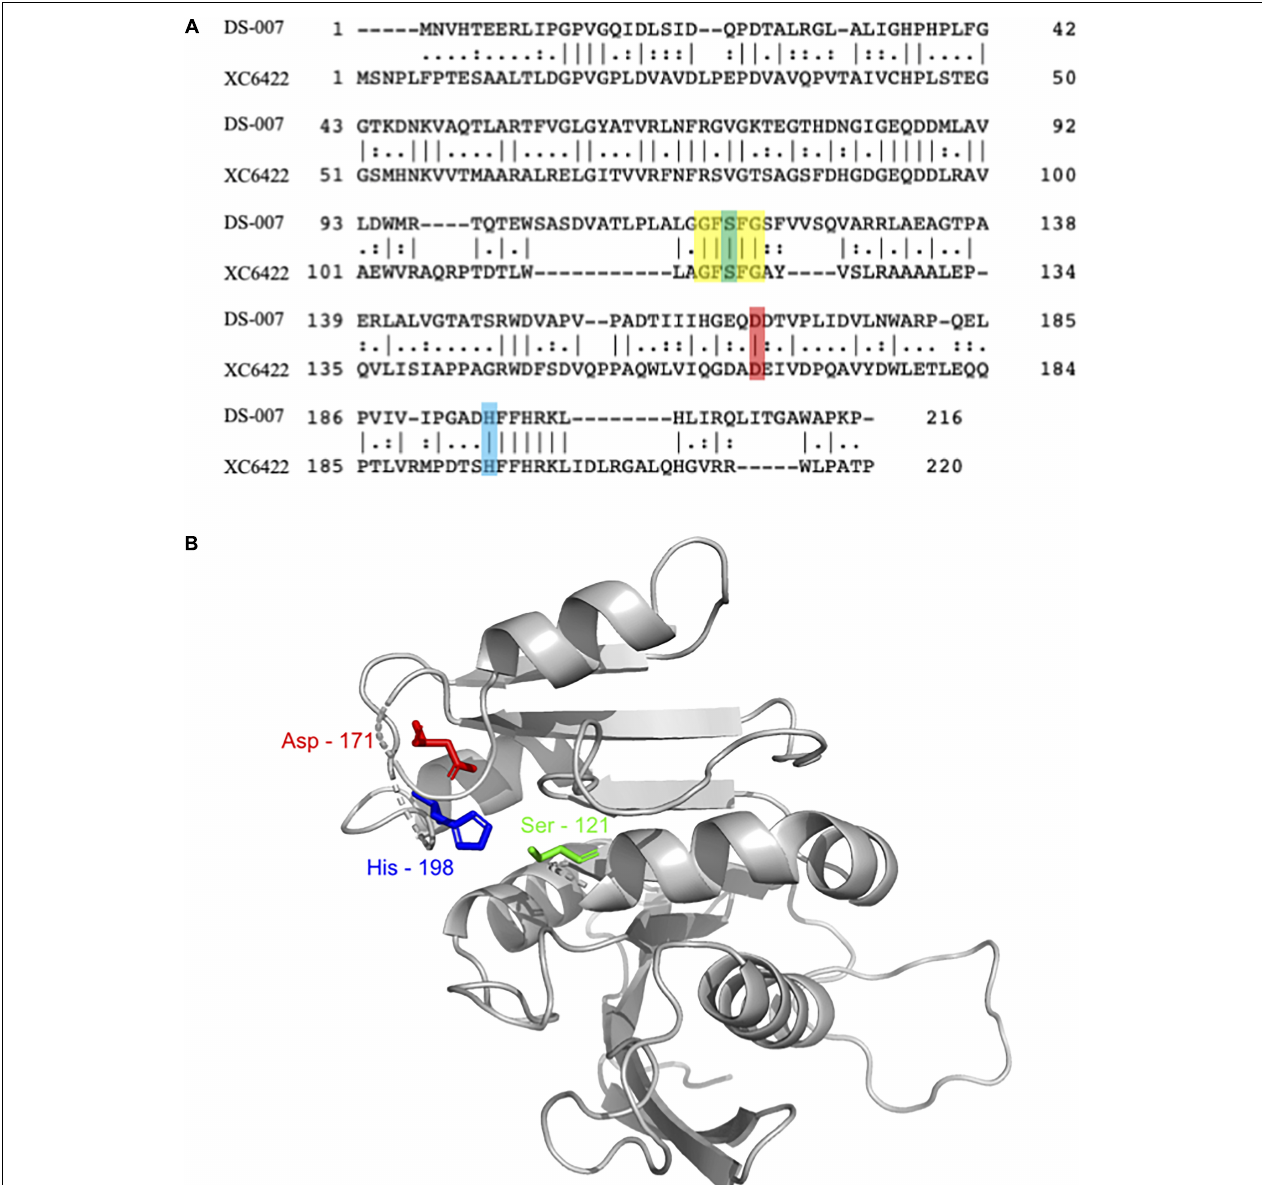
FIGURE 2 | (A) Sequence alignment of DS-007 with XC6422 from Xanthomonas campestris (structure template based on this enzyme) showed an identity of 33.6% (Madeira et al., 2019). Residues forming the catalytic triad [serine, (121), aspartic acid (171), and histidine (198)] are highlighted in green, red and blue, respectively. The pentapeptide G-F-S-F-G is highlighted in yellow. (B) Three-dimensional structure of DS-007 was modeled with Phyre 2 server (Kelley et al., 2015) against the d2fuka template (based on XC6422). Ser-121, Asp-171, and His-198, predicted to form the catalytic triad of DS-007 are in close proximity. The absence of a lid indicates that DS-007 is probably an